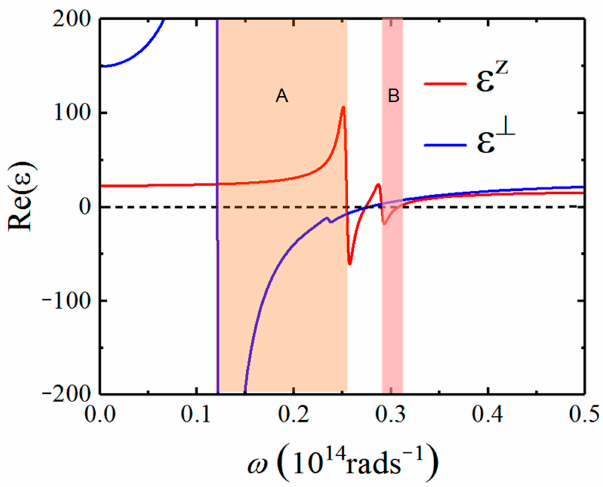
Figure 2. The real part of the dielectric function of Bi 2 Se 3 . The shaded regions denote the hyperbolic regions. Regions A and B denote type II (Re hyperbolic bands,